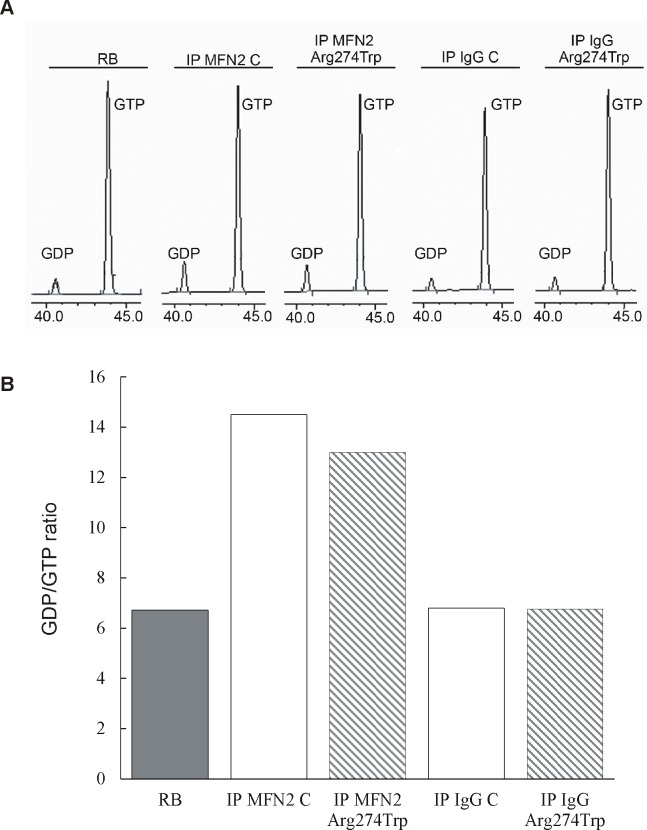
GTP-hydrolysis activity of mitofusin 2 obtained from control and proband-derived fibroblasts.GTPase activity of control and mutated MFN2 presented as HPLC traces (A) and GDP/GTP ratio (B). Endogenous MFN2 was immunoprecipitated from 300 μg PNS lysates obtained from control (IP MFN2 C) and proband-derived fibroblasts (IP MFN2 Arg274Trp) and incubated with GTP at 37°C for 60 minutes, before HPLC analysis as described in Methods. In parallel, immunoprecipitation with nonspecific rabbit antibody was performed with PNS lysates obtained from control (IP IgG C) and proband-derived fibroblasts (IP IgG Arg274Trp). RB–reaction buffer containing 100 μM GTP.